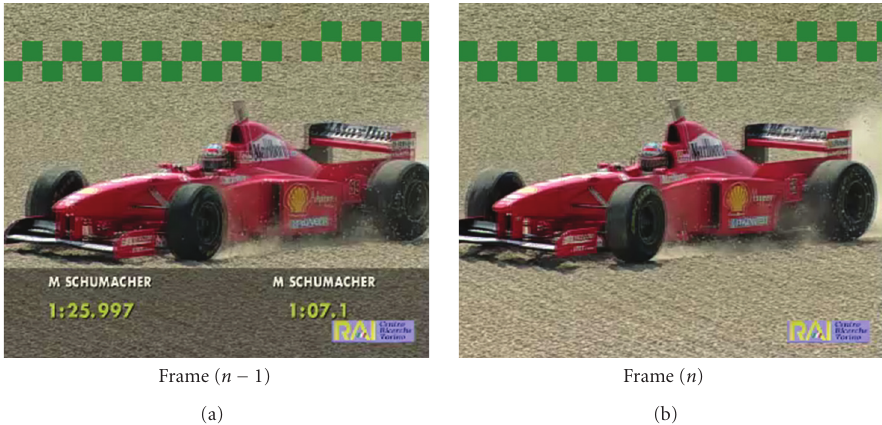
Figure 10: False scene change detection caused by lost MBs in the 12.5 fps sequence, for a 4% packet loss rate.